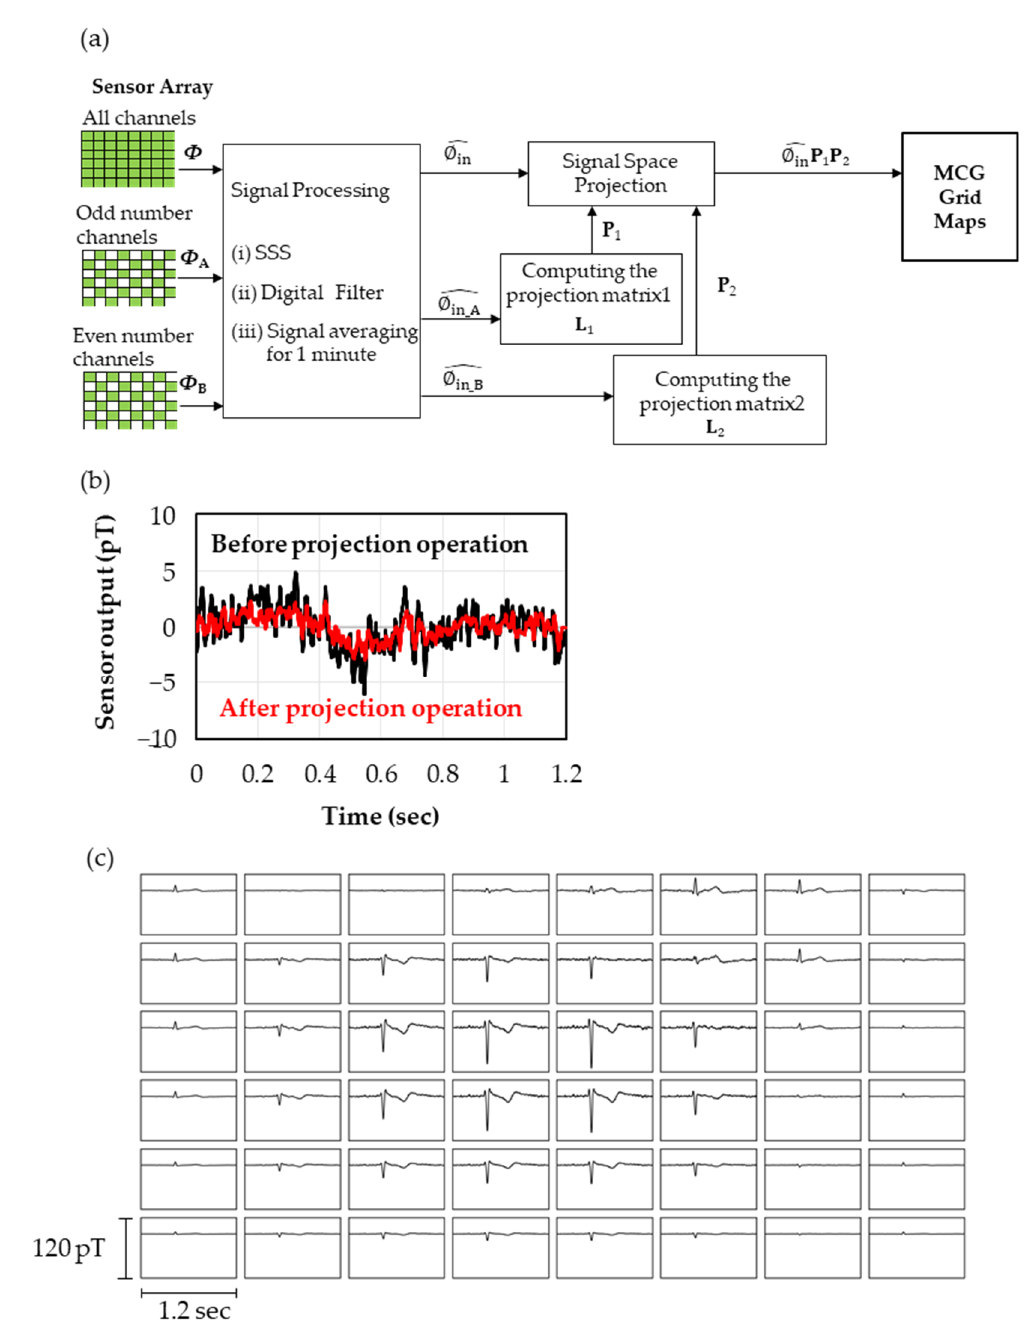
Figure 5. ( a ) Processing flow of projection operation. ( b ) Time series of Z -sensors in the lower layer in ch2 measured without the subject to evaluate the change of noises before and after the projection operation. The standard deviation before and after the projection operation was calculated to be 1.77 pT rms and 0.99 pT rms , respectively. ( c ) Magnetocardiogram map obtained with the Z -sensors in the lower layers in 48 channels after SSS, digital filter, signal average and projection operation.